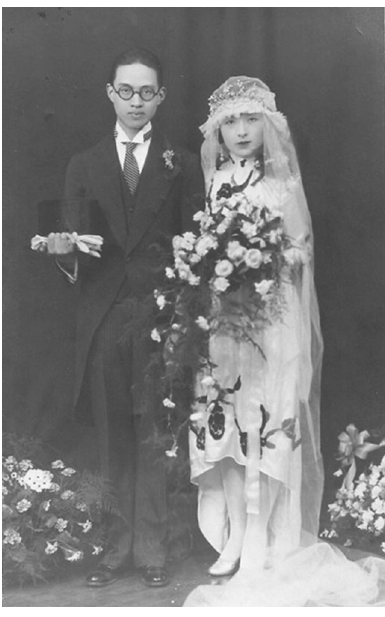
Figure 2. In the spring of 1930, Chi-Nan Hu married with Chu-Chen Yu ( 俞 竹 贞 ), a child psychologist, in Shanghai. After wedding, they both studied in the USA (http://blog.sina.